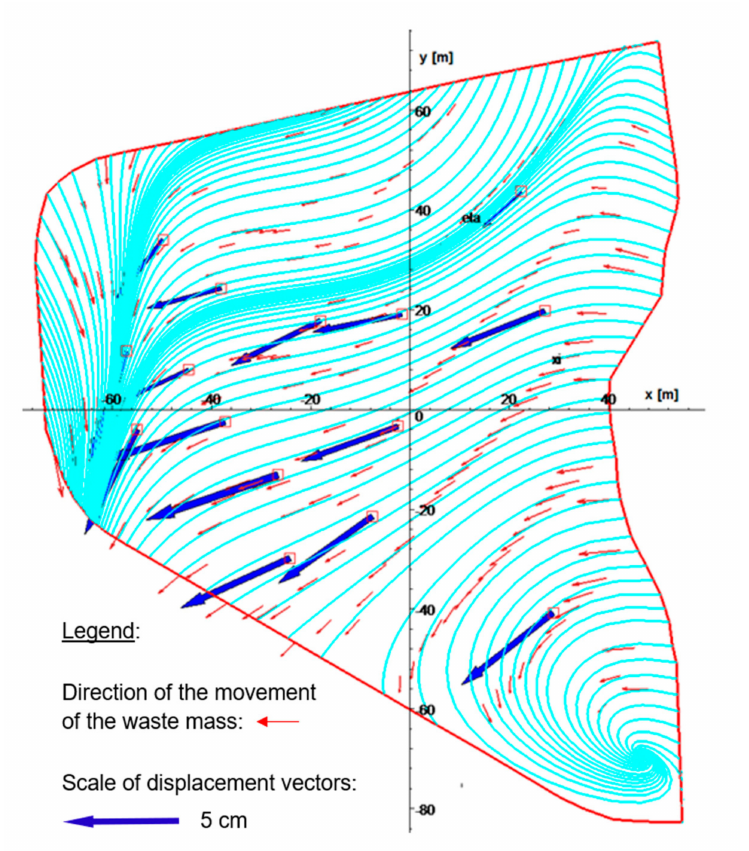
Figure 11. Trajectories of landfill material